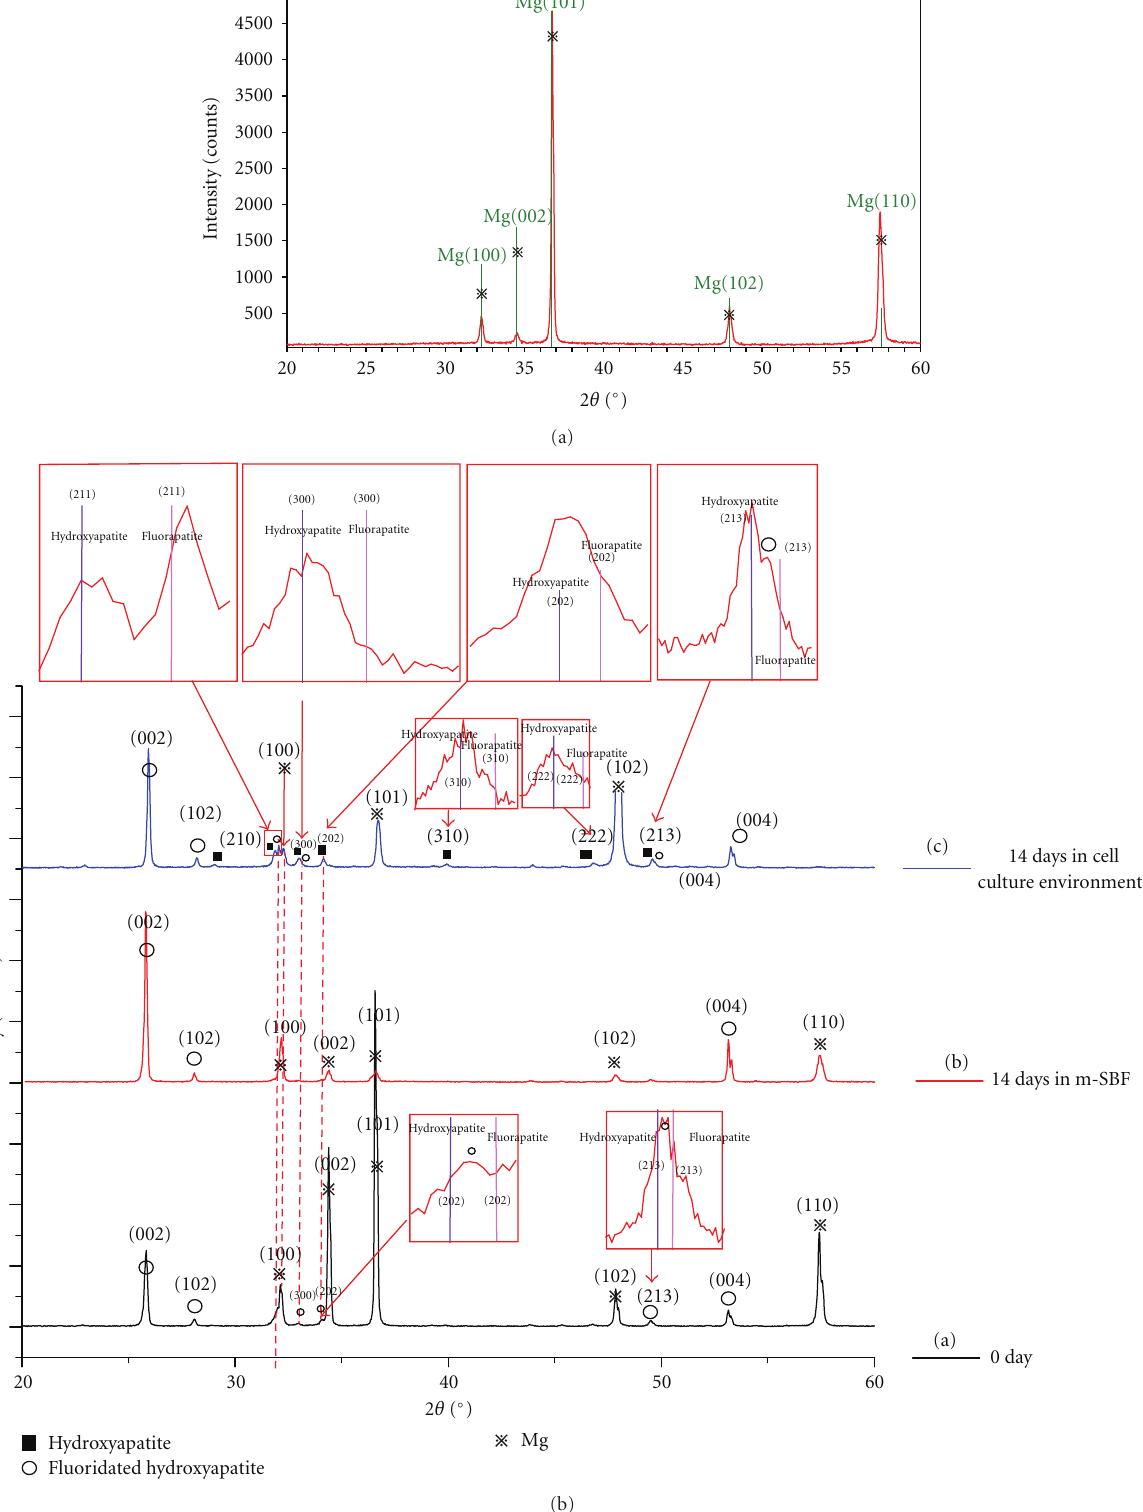
Figure 2: Typical XRD di ff raction pattern. (a) The result on the Mg-Zn alloy after 14 days’ culture and detaching the cells from the sample. (b) The result on the FHA-coated one. Curve-a presents the di ff raction pattern of the FHA coatings right after the electrodeposition. Curve-b presents the pattern of the FHA coatings after being immersed in m-SBF for 14 days. Curve-c presents the di ff raction pattern of the FHA coatings after 14 days’ culture in cell culture environment and detaching the cells from the